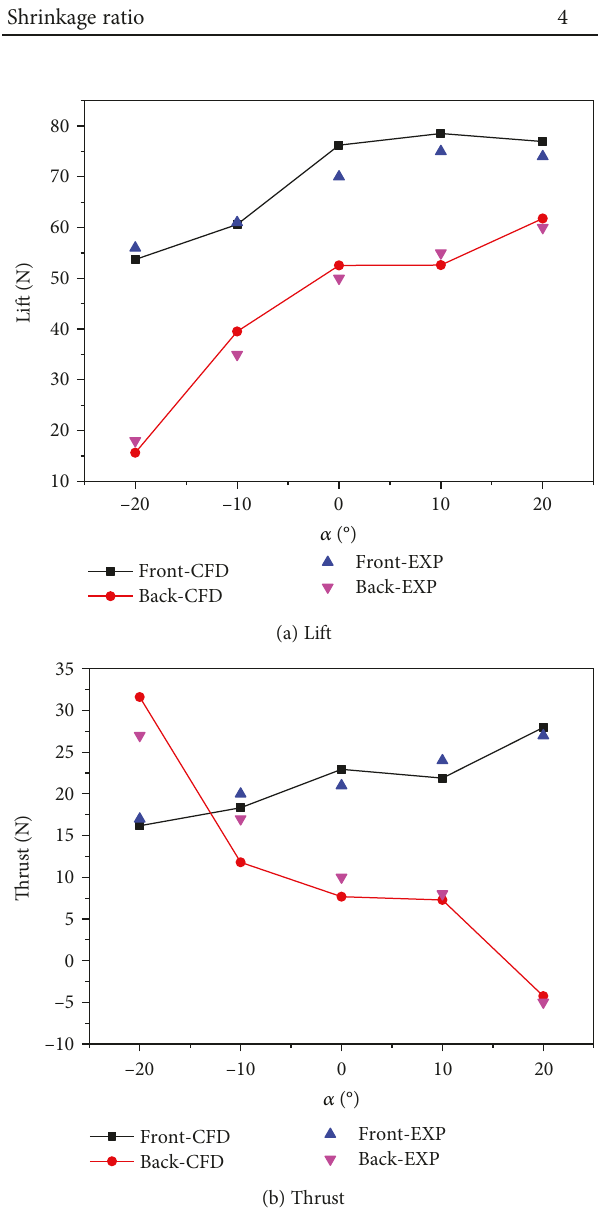
Figure 21: Comparison curves between numerical results and experimental results when the front wing is fi xed.